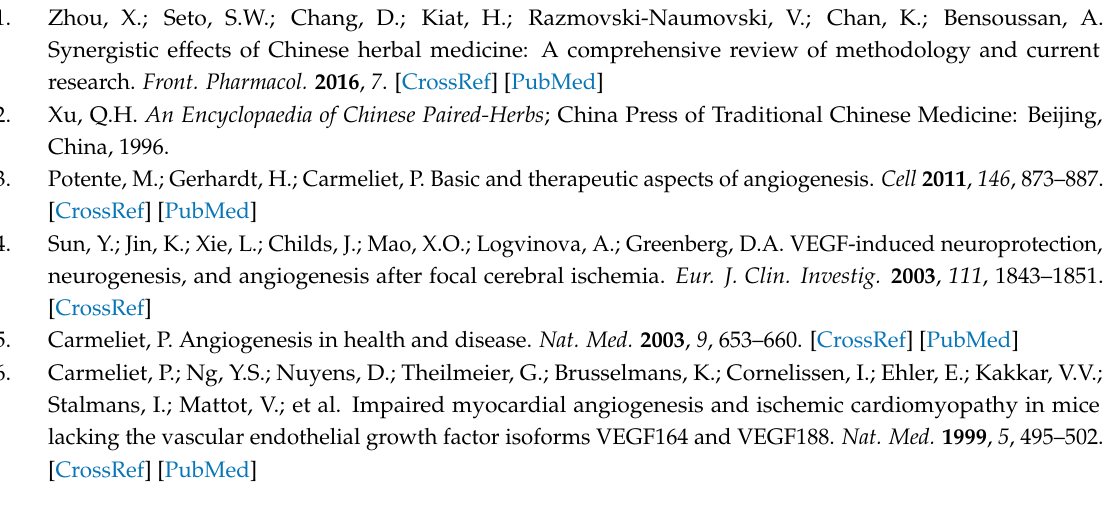
Figure S1: Chemical fingerprint of raw herb extract of DS ( A ) and SQ ( B ) analyzed by UPLC-PDA. (1) NR1, (2) Rg1, (3) Rb1, (4) Rg2, (5) Rd, (6) DSS, (7) SB, (8) SA, (9) DT, (10) CT, (11) T1 and (12) TIIA [40], Figure S2: Contents (mg/g, mean ± SD, n = 3) of DSS, SB, NR1, Rg1 and Rb1 in DS-SQ combinations extract by